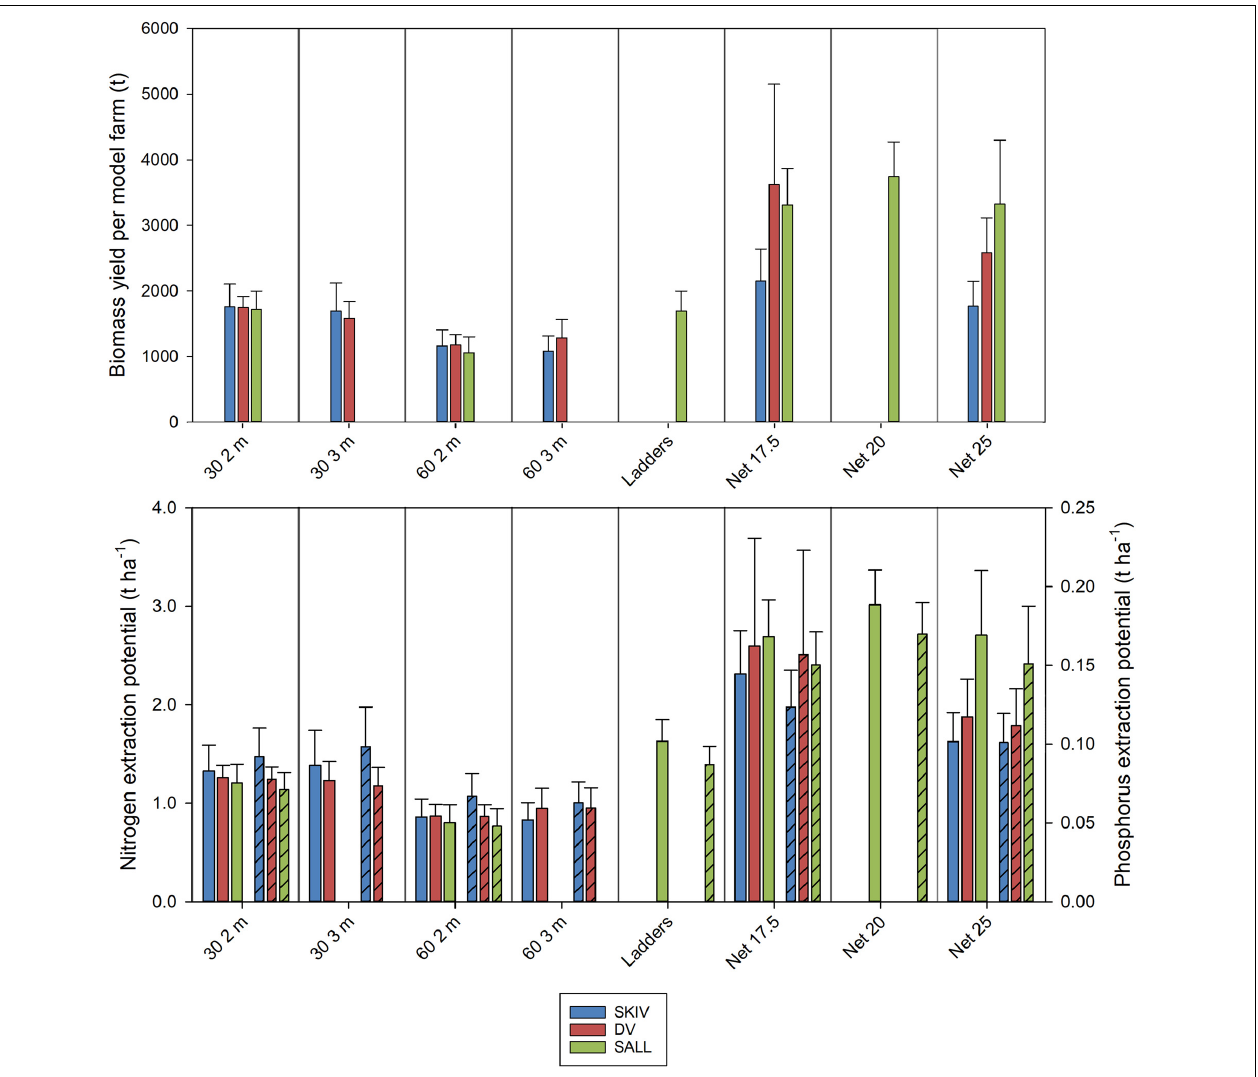
FIGURE 5 | Upper panel: Biomass yield per model farm (t) by cultivation treatment. Lower panel: Nitrogen extraction (left axis) and phosphorus extraction (right axis, bars hashed) per hectare by cultivation treatment. Farms are represented by color; SKIV (blue), DV (red), SALL (green). Error bars represent standard deviations.